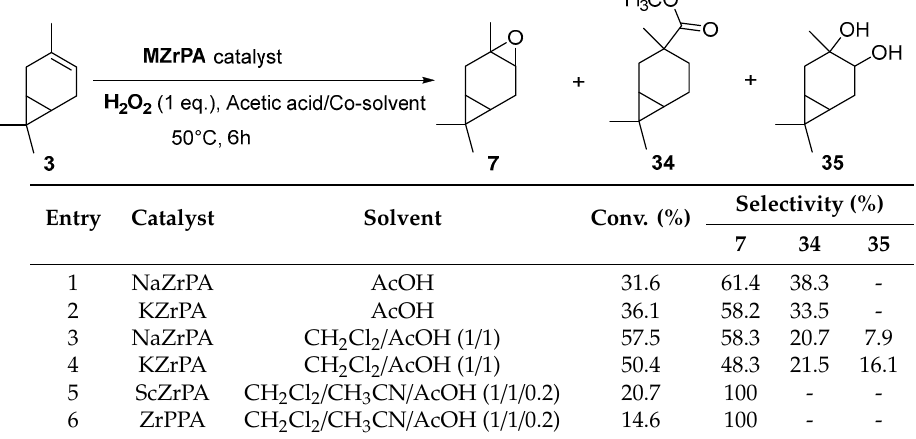
a Reaction conditions: Catalyst (58 mg), 3-carene (2.2 mmol), H 2 O 2 (1 eq., 35% w/w), 2 mL solvent, 50 °C, 6 h, PA = Phosphate, PPA = Phosphonate .